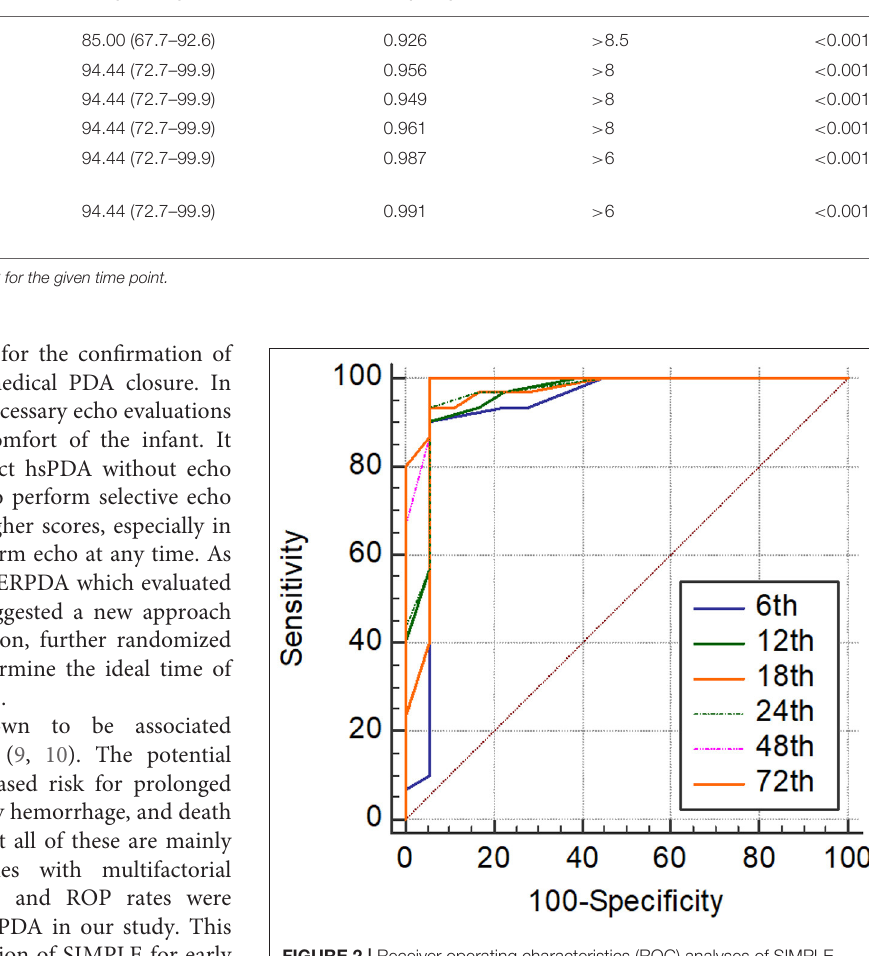
TABLE 7 | Receiver operating characteristics (ROC) curve statistics for SIMPLE scores at various time points 6–72h. Time point